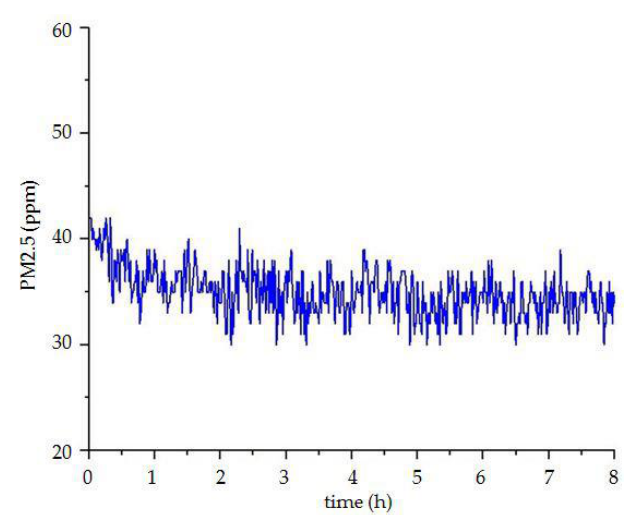
Figure 22. The curve of PM2.5 concentration.